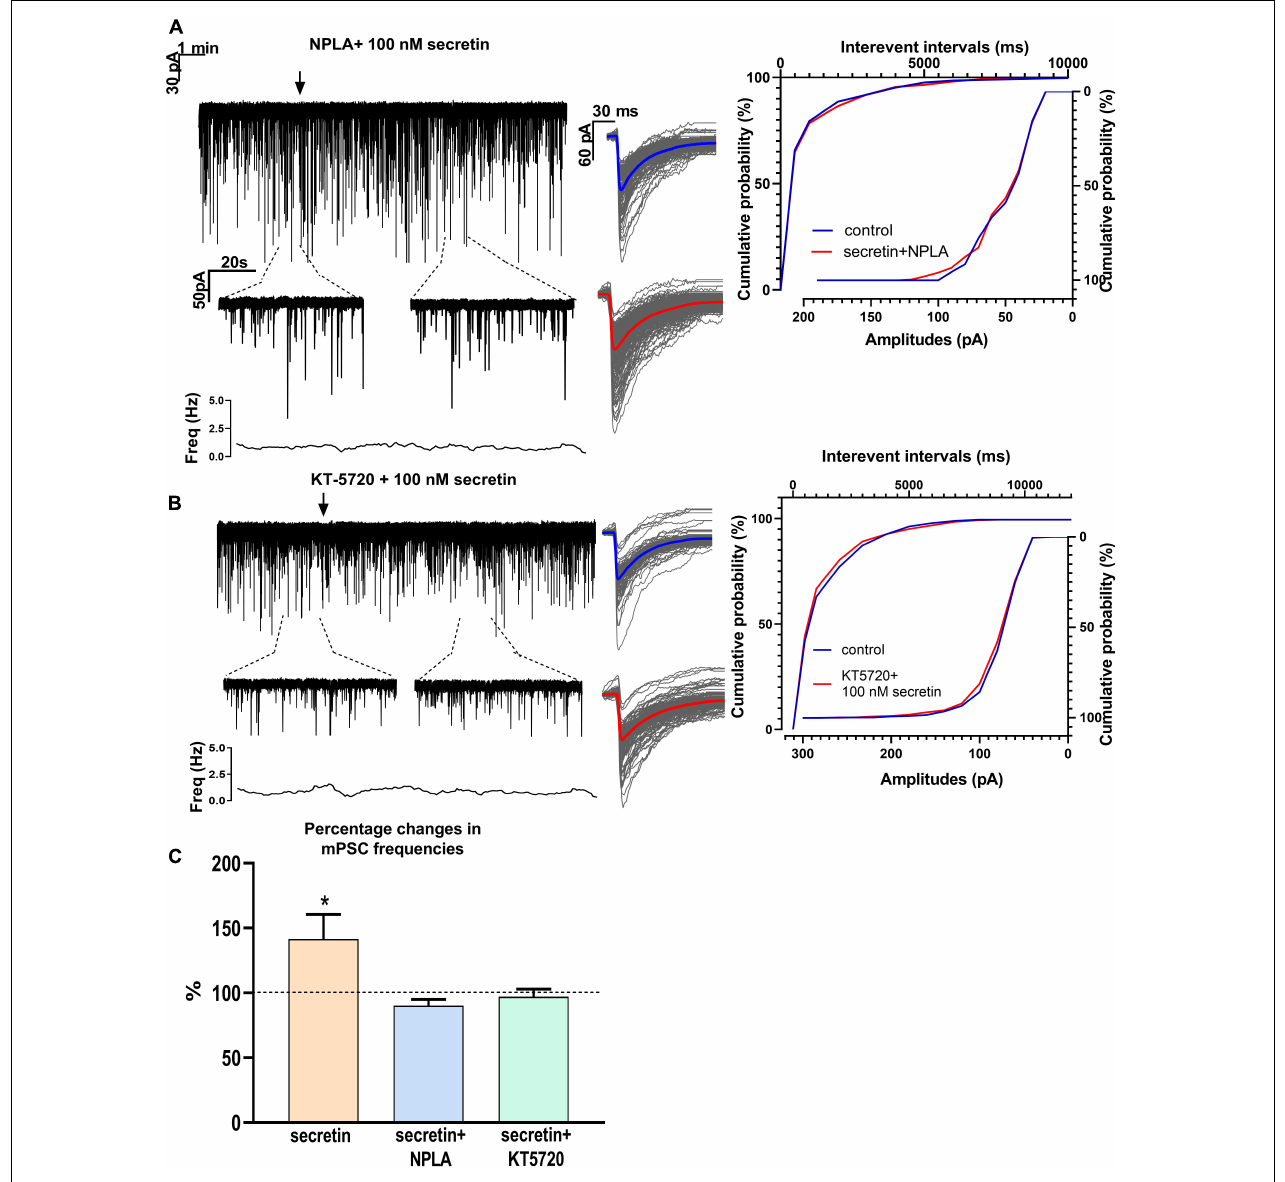
FIGURE 4 | Effects of various blockers on the secretin-evoked increase in the frequency of mPSCs in GnRH neurons. (A) Intracellular application of the nNOS blocker NPLA extinguished the effect of secretin. (B) The PKA inhibitor KT5720 applied intracellularly, also eliminated the effect of secretin. (C) Bar graph shows that secretin utilizes PKA- and retrograde NO-coupled signaling mechanisms. The inserts below the 15 min recordings are 1-1 min zoomed periods from the recordings before and after secretin administration. The frequency distribution is also presented under each recording Average mPSCs beside each recording showed change in the shape or amplitudes of events after secretin treatment. Cumulative probabilities of the interevent intervals are graphed next to the individual events. Arrow shows the administration of secretin ( ∗ p <